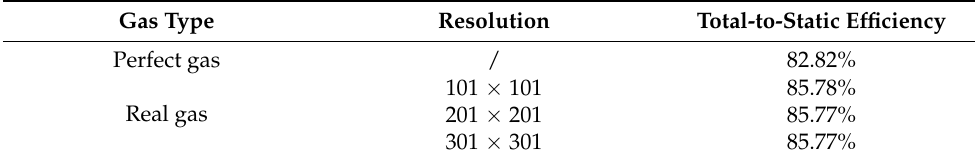
Table 5. Table resolution test of the thermal-physical properties.